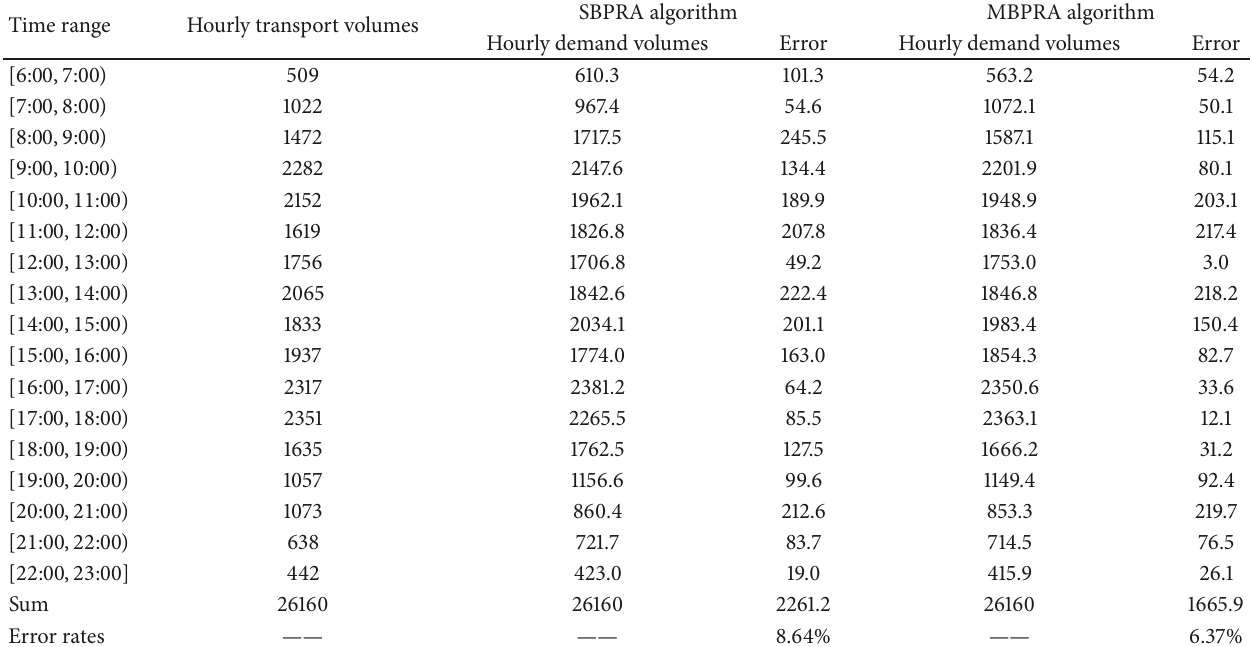
Table 10: Error analysis for the SBPRA algorithm and the MBPRA algorithm. Time